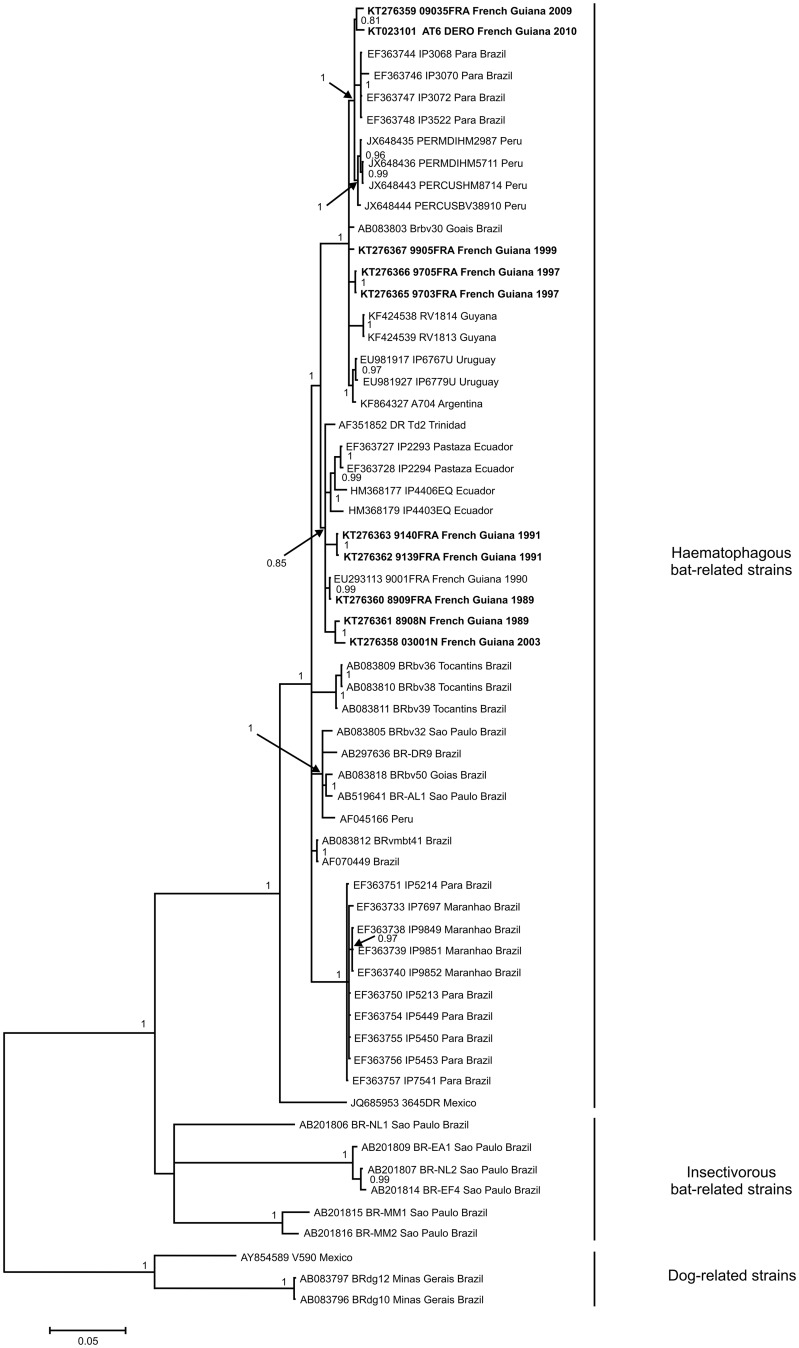
Phylogenetic tree constructed using Bayesian methods based on 1314 nucleotides of the nucleoprotein gene.Virus names are associated with their accession numbers. Novel sequences generated from the two rabid bats in this study are shown in bold. Support for nodes is provided by the posterior probabilities of the corresponding clades. All resolved nodes have a posterior probability greater than 0.8. Scale bar indicates nucleotide sequence divergence among sequences.